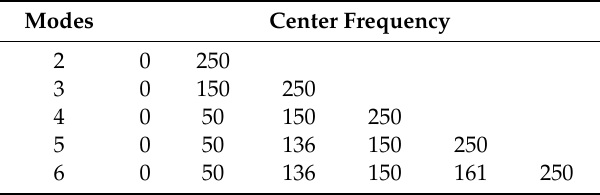
Figure 4. Performance of input DC voltage under noise-free condition: ( a ) amplitude, ( b ) spectrum. Table 1. Center frequency corresponding to different K.